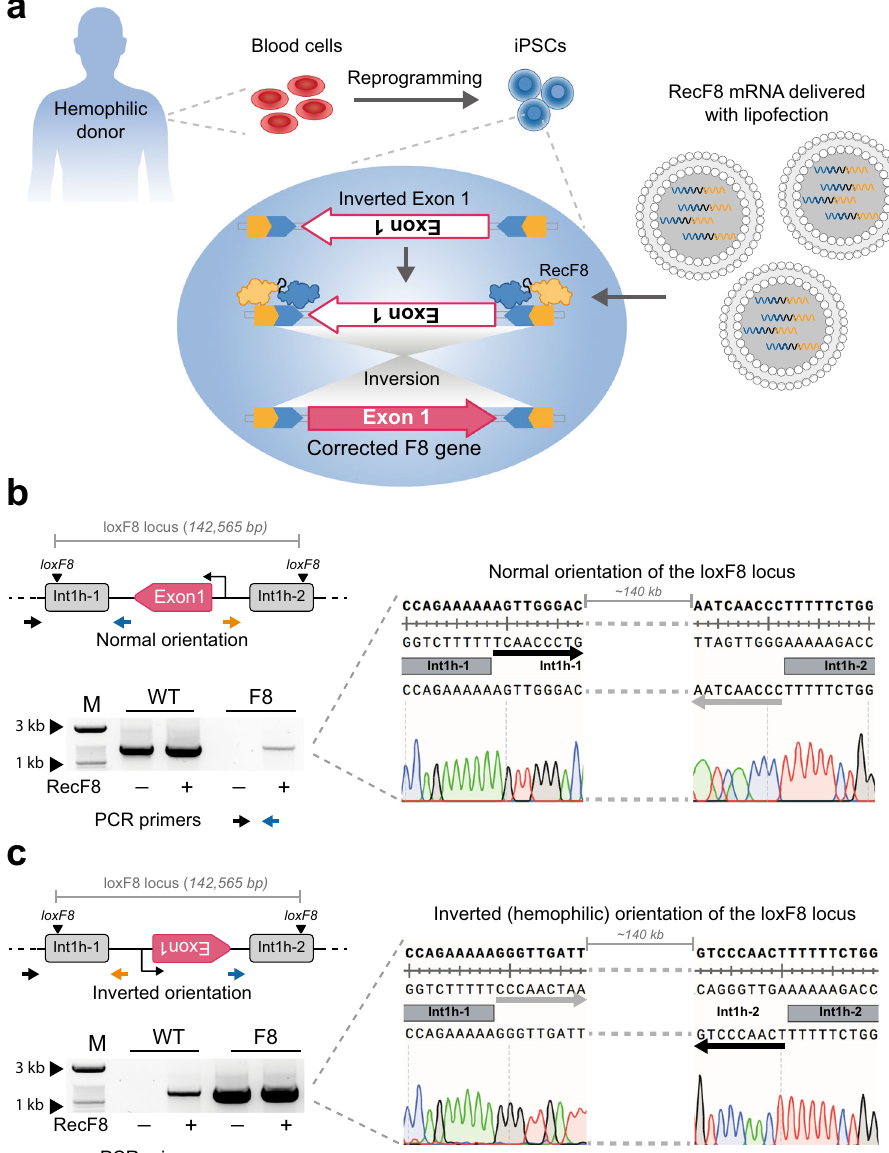
Fig. 5 Correction of exon 1 inversion in patient-speci fi c cells. a Schematic representation of the generation of patient-speci fi c induced pluripotent stem cells (iPSCs) and treatment with RecF8 mRNA. A magni fi cation of the nucleus is shown with a schematic depiction of the loxF8 locus before and after treatment with RecF8. The two loxF8 target sites are shown in yellow and blue. b PCR-based detection of the loxF8 locus in WT and patient-derived iPSCs with and without RecF8 treatment. Employed primers are depicted in the illustration by arrows in black, blue and orange. c PCR-based detection of inverted loxF8 locus in WT and patient-derived iPSCs with and without RecF8 treatment. Sequencing reads of the PCR products con fi rming the corrected orientation of the DNA sequence after RecF8 treatment are displayed. The black and gray arrows indicate the sequence orientation between the int1h-1 and int1h-2 repeats of the loxF8 locus. Marker (M) lanes at 1 kb and 3 kb are indicated. WT = iPSCs from a donor that does not carry the exon 1 inversion of the F8 gene. F8 = iPSCs from a hemophilic donor carrying the exon 1 inversion of the F8 gene. Source data are provided as a Source data fi